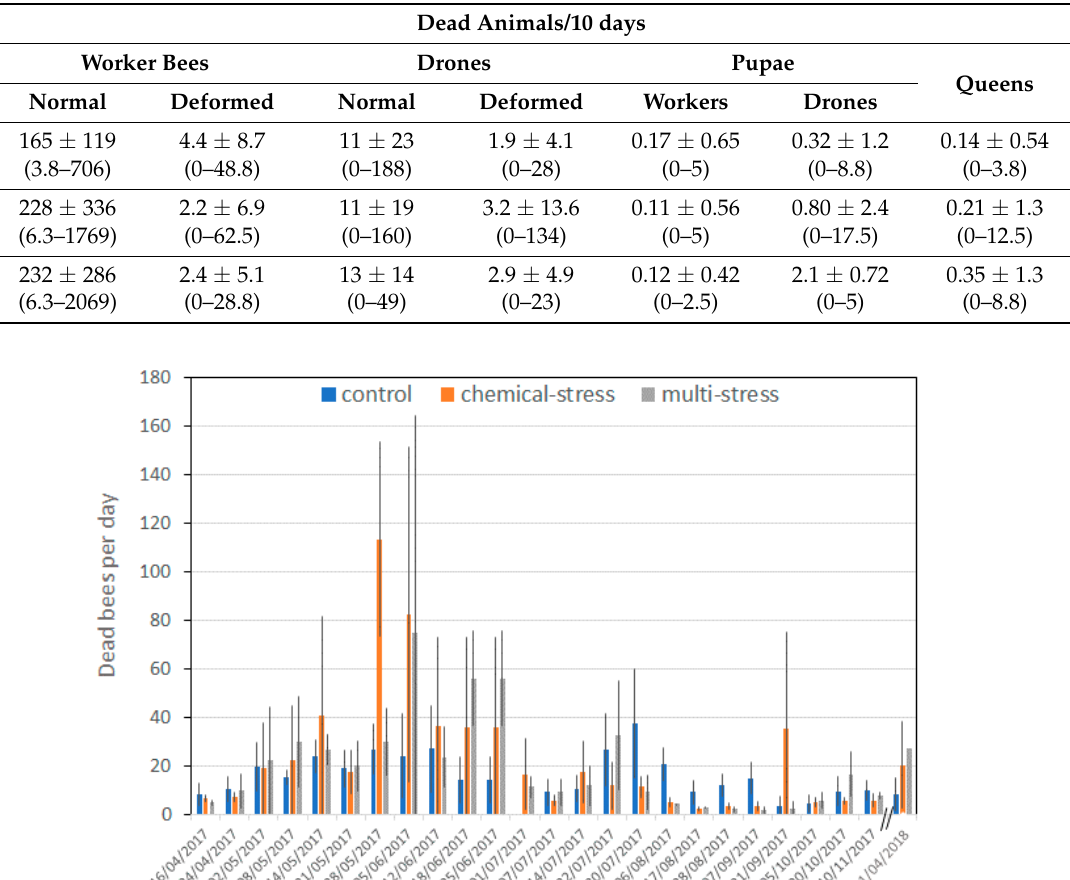
Table 4. Mean number ± standard deviation (minimum-maximum interval in brackets) of dead specimens in 10 days found in the underbasket in control, chemical- and multi-stress sites.